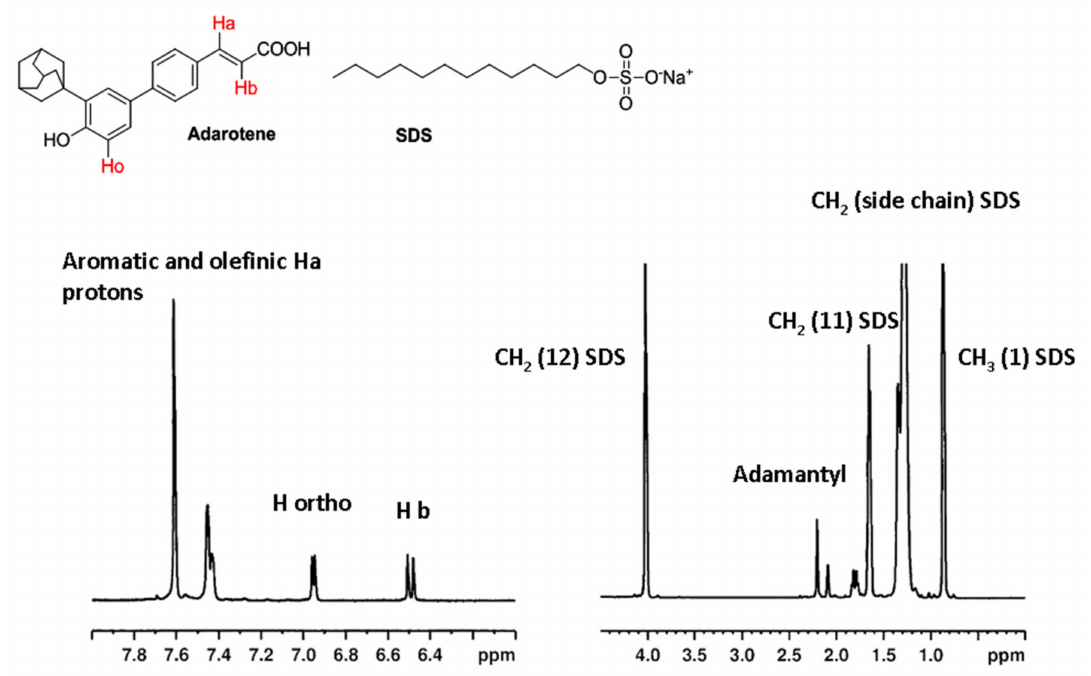
Figure 3. 1 H NMR spectrum of adarotene + SDS micelles in D 2 O, T = 25 ◦